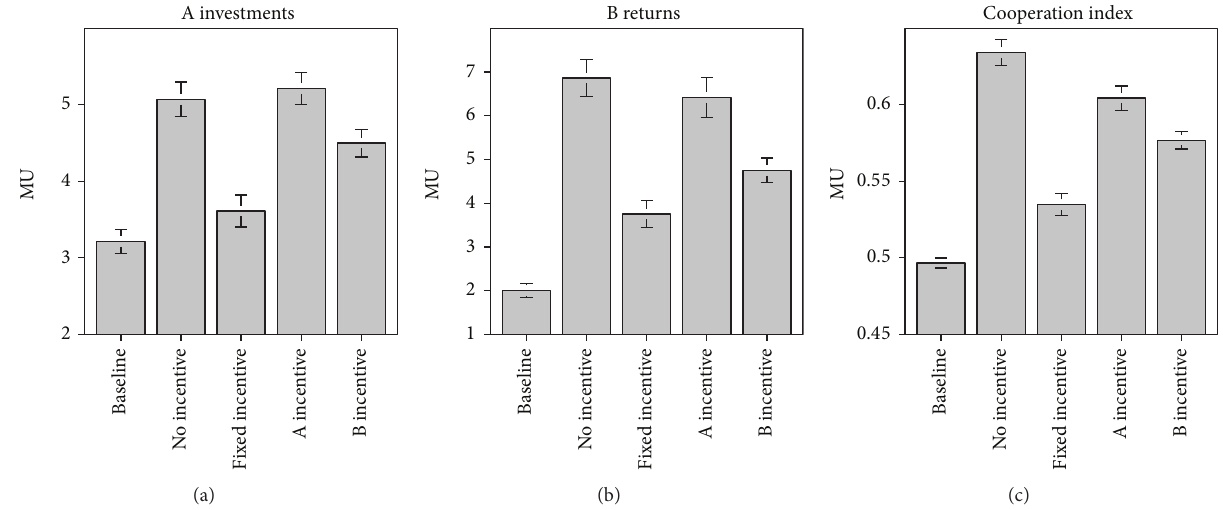
Figure 1: Experiment 2 results. Average investments, returns, and CI by treatment. Bars show the standard error of the means.